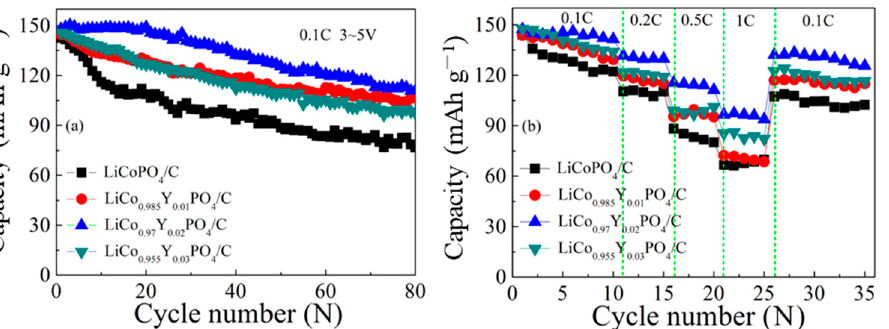
Figure 9. The cycling stability ( a ) and rate ( b ) performances of the four electrodes. Table 3. Cycling performance of the LiCo 0.97 Y 0.02 PO 4 /C electrode in comparison with others reported.